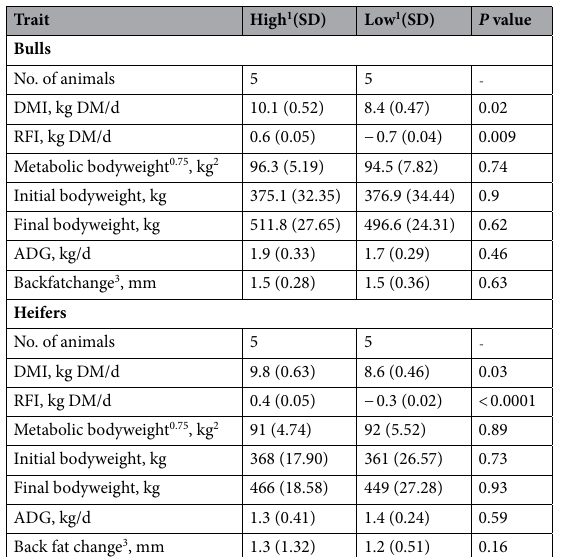
Table 1. Summary of phenotypic data of bulls at end of feed intake trial. 1 High RFI is inefficient and low RFI is efficient. 2 Metabolic BW 0.75 , kg is determined as BW 0.75 in the middle of the RFI measurement period which was estimated from the intercept and slope of the regression line after fitting a linear regression line through all metabolic BW (BW 0.75 ) observations. 3 Back fat change is mean of the fat depth at end of intake trial—mean of fat depth at start of intake trial.